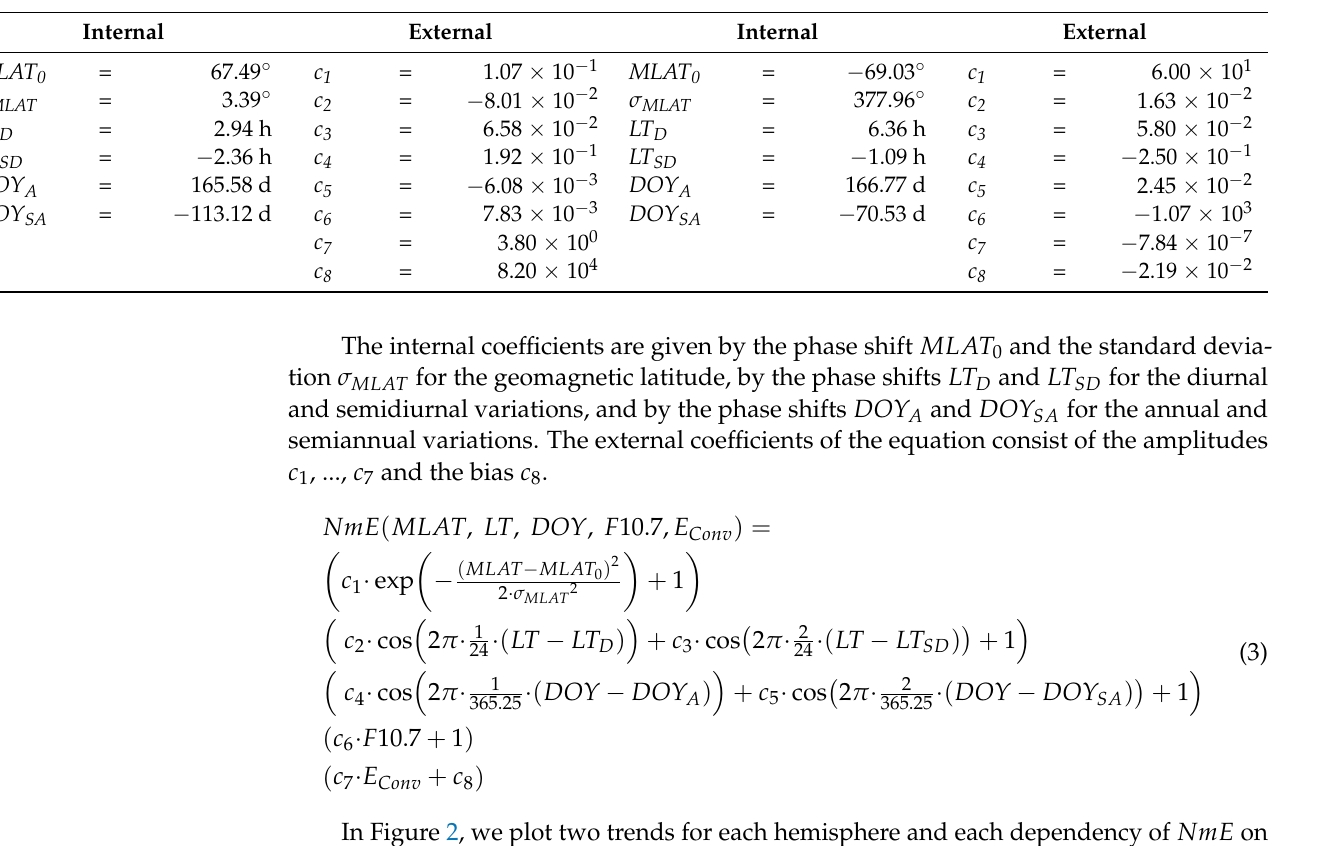
Table 2. Coefficients of the E layer peak electron density (NmE) model for the Northern and Southern Hemispheres. NmE Model Coefficients North NmE Model Coefficients